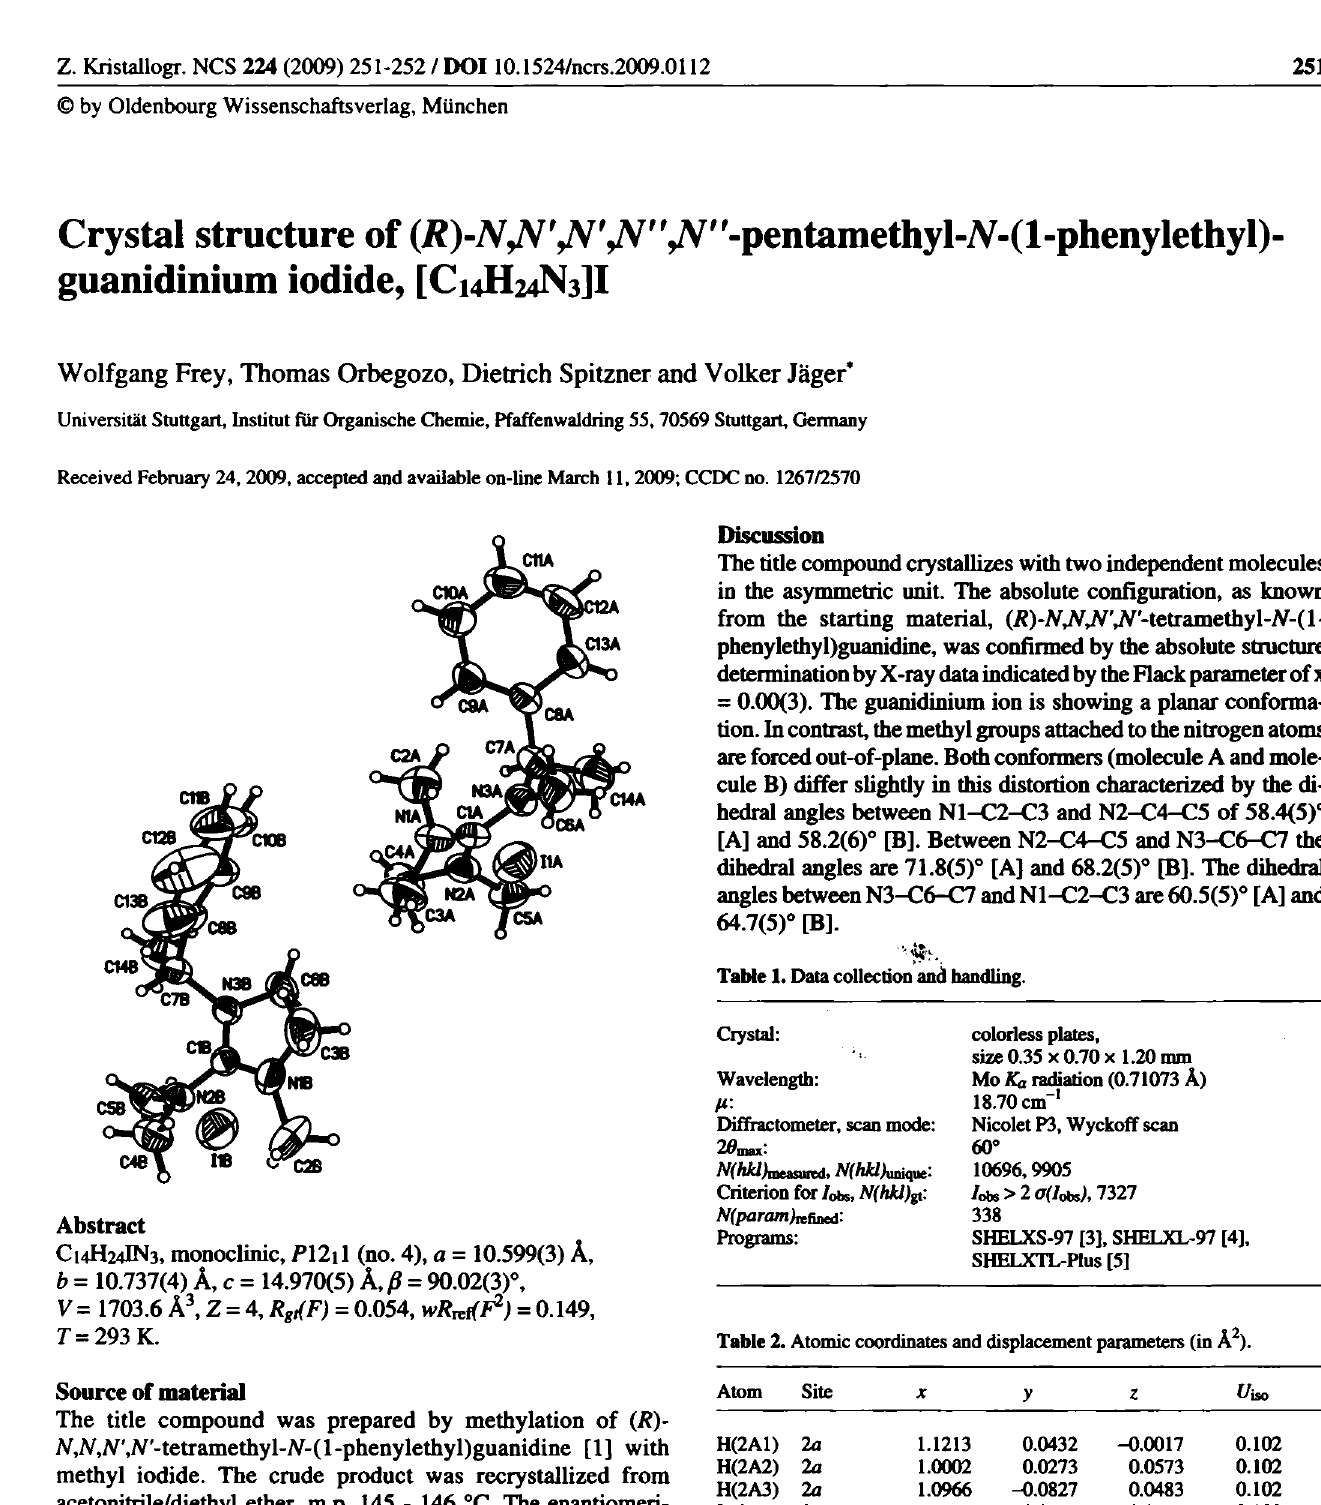
Table 2. Atomic coordinates and displacement parameters (in Â 2